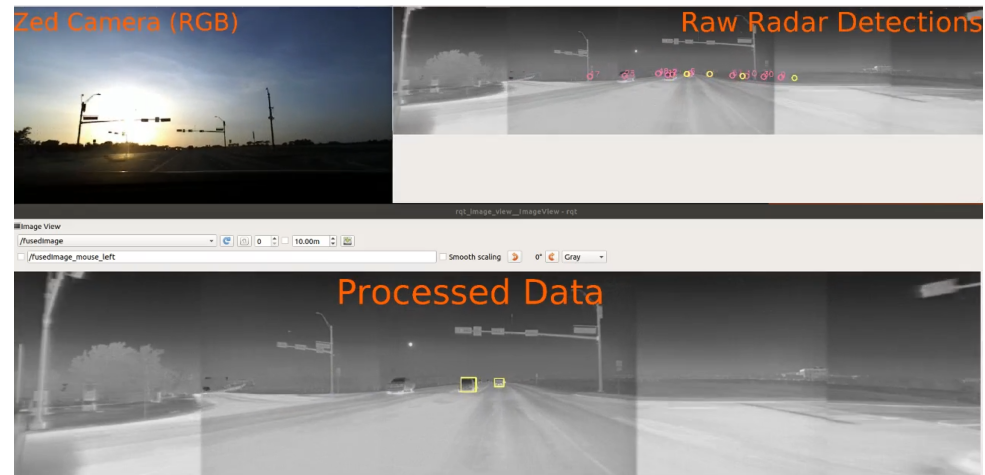
Figure 11. A screenshot showing the object tracking algorithm running under poor visibility conditions. The pink and yellow circles on the top right show the confirmed detections and clutter respectively from the radar. The yellow boxes in the bottom show the final vehicle tracks after sensor